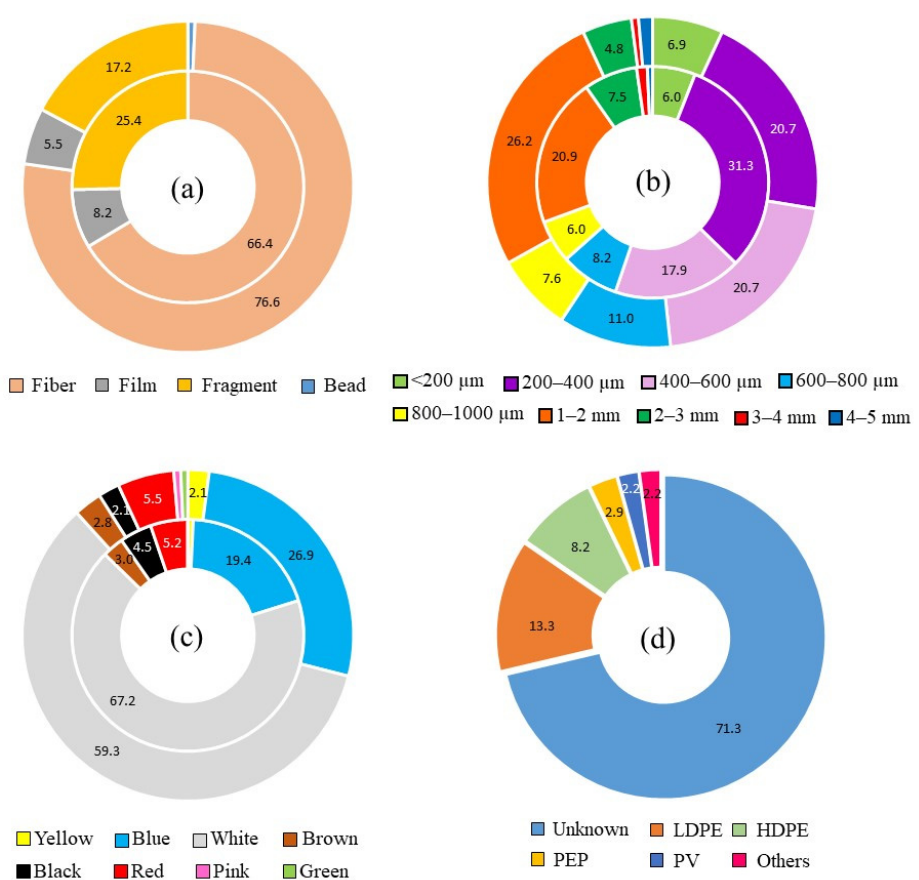
Figure 3. Accumulated percentages of MP ingested by CGS: ( a ) shapes; ( b ) size categories, based on Spanish Environmental Ministry classification; ( c ) colors; ( d ) polymer types (inner ring stands for stomach samples, and outer ring stands for intestine samples).